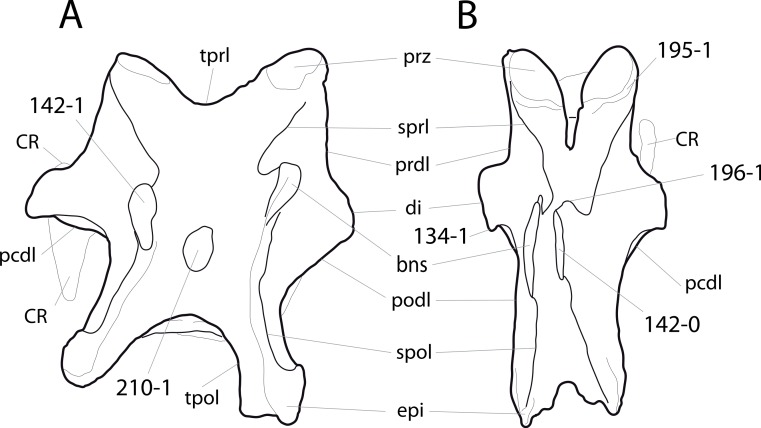
Diplodocid mid- to posterior cervical vertebrae.Mid- to posterior cervical vertebrae of Apatosaurus ajax YPM 1860 (A; traced from a photo by M Taylor), and Kaatedocus siberi SMA 0004 (B; CV 13, traced from Tschopp & Mateus, 2013b) in dorsal view (anterior to the top). Note the triangular posterior projection on the diapophysis in Kaatedocus (B; C134-1), the transversely compressed (B; C142-0) in contrast to rounded (A; C142-1) neural spine summits, the transverse sulcus accompanying the prezygapophyseal facet posteriorly in Kaatedocus (B; C195-1), the anterior bulge of the sprl, just below the spine summit, characterizing most diplodocines (B; C196-1), and the median tubercle visible in Apatosaurus (A; C210-1). Abb.: bns, bifid neural spine; CR, cervical rib; di, diapophysis; epi, epipophysis; pcdl, posterior centrodiapophyseal lamina; podl, postzygodiapophyseal lamina; prdl, prezygodiapophyseal lamina; prz, prezygapophysis; spol, spinopostzygapophyseal lamina; sprl, spinoprezygapophyseal lamina; tpol, interpostzygapophyseal lamina; tprl, interprezygapophyseal lamina. Vertebrae scaled to same total length.